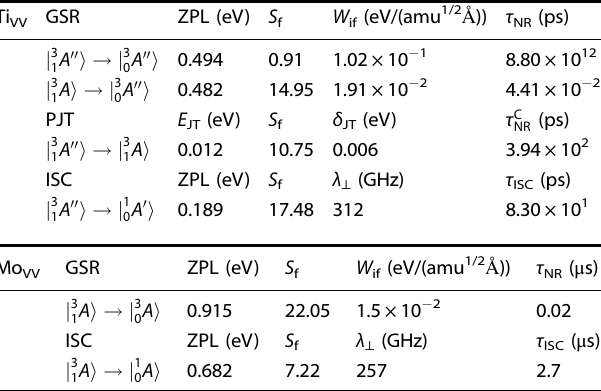
Table 2. Various nonradiative recombination lifetimes along with relevant quantities for the Ti VV and Mo VV defects in h -BN, including ground state recombination (GSR), pseudo-Jahn – Teller (PJT), and intersystem crossing